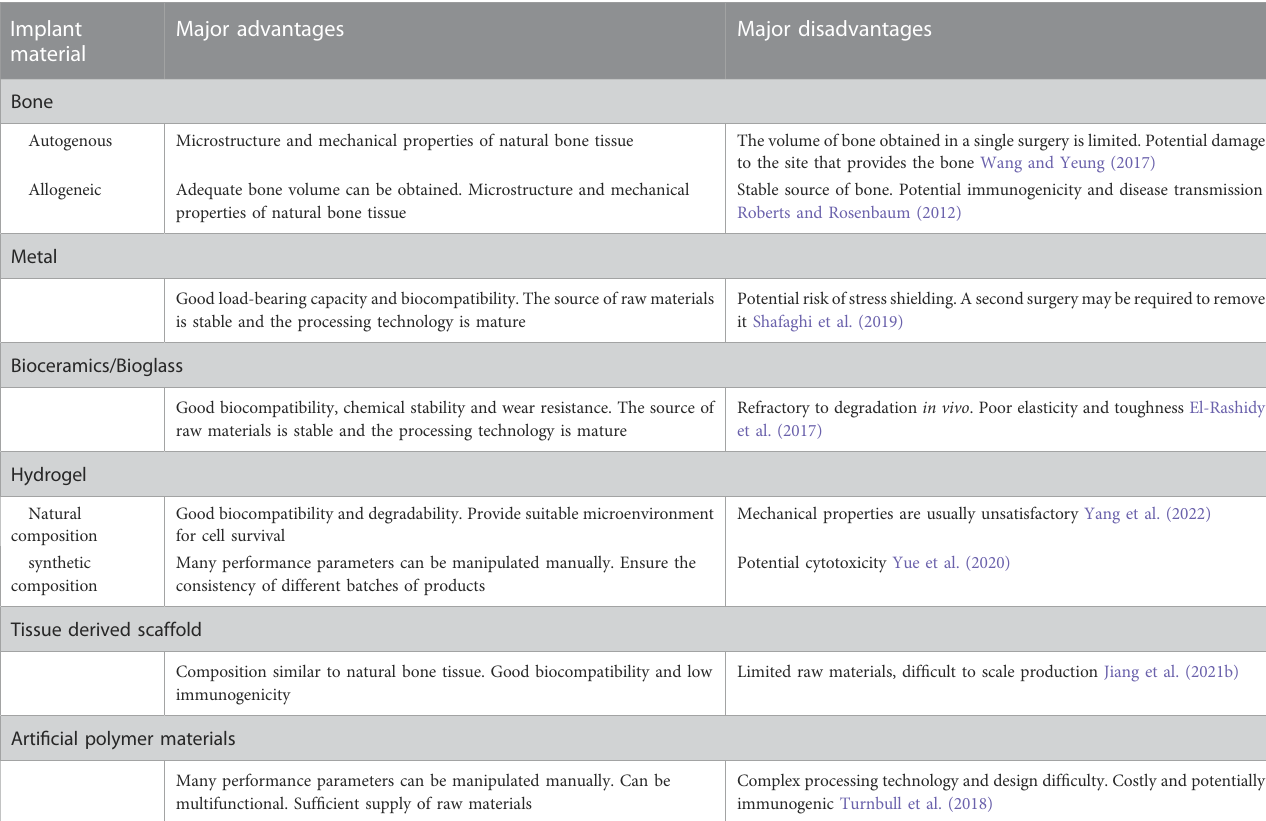
Major advantages